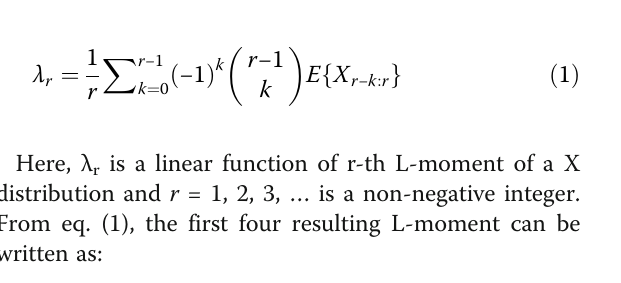
Table 1 List and type of the five rainfall stations ’ utilized for analysis Rainfall station GPS point Region Elevation (m) Period of data